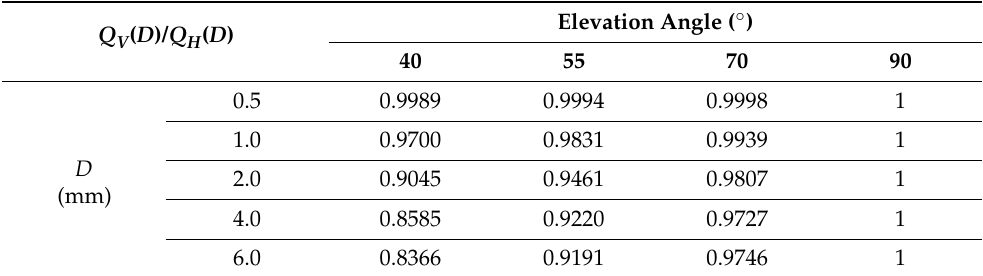
Table 2. The extinction cross section ratio of vertical to horizontal polarizations calculated by the T-Matrix method for various raindrop sizes and elevation